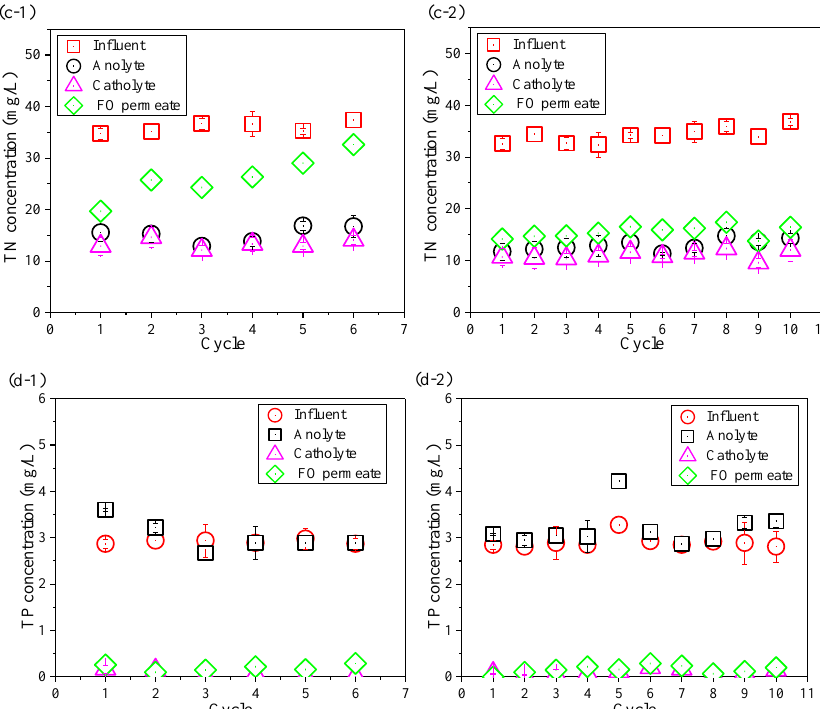
Figure 4. Variations in ( a ) total organic carbon (TOC), ( b ) NH 4 + –N, ( c ) total nitrogen (TN), and ( d ) total phosphorous (TP) concentrations in the influent, anolyte, catholyte, and FO permeate at the end of each cycle in (1) the control OsMFC and (2) the AgNP-OsMFC, respectively.